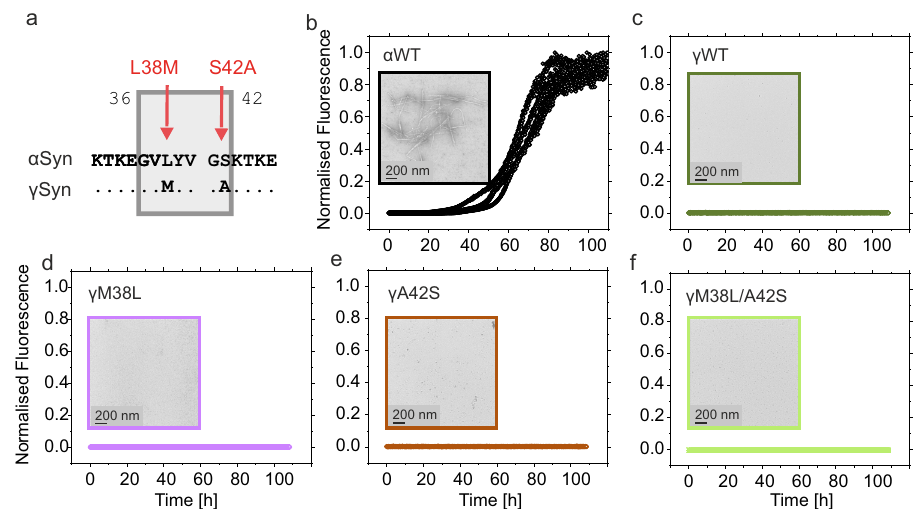
Fig. 7 | Sequence alterations in P1 do not result in aggregation of γ Syn. a Sequence alignment of α Syn and γ Syn focussing on the P1 region (boxed). Resi-